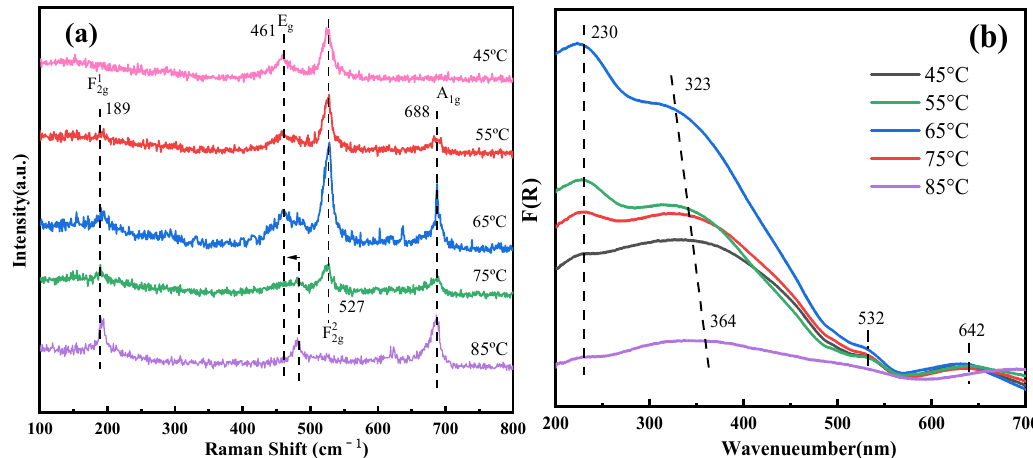
Figure 4. ( a ) Raman spectra of catalysts; ( b ) UV–Vis DRS spectra of catalysts.